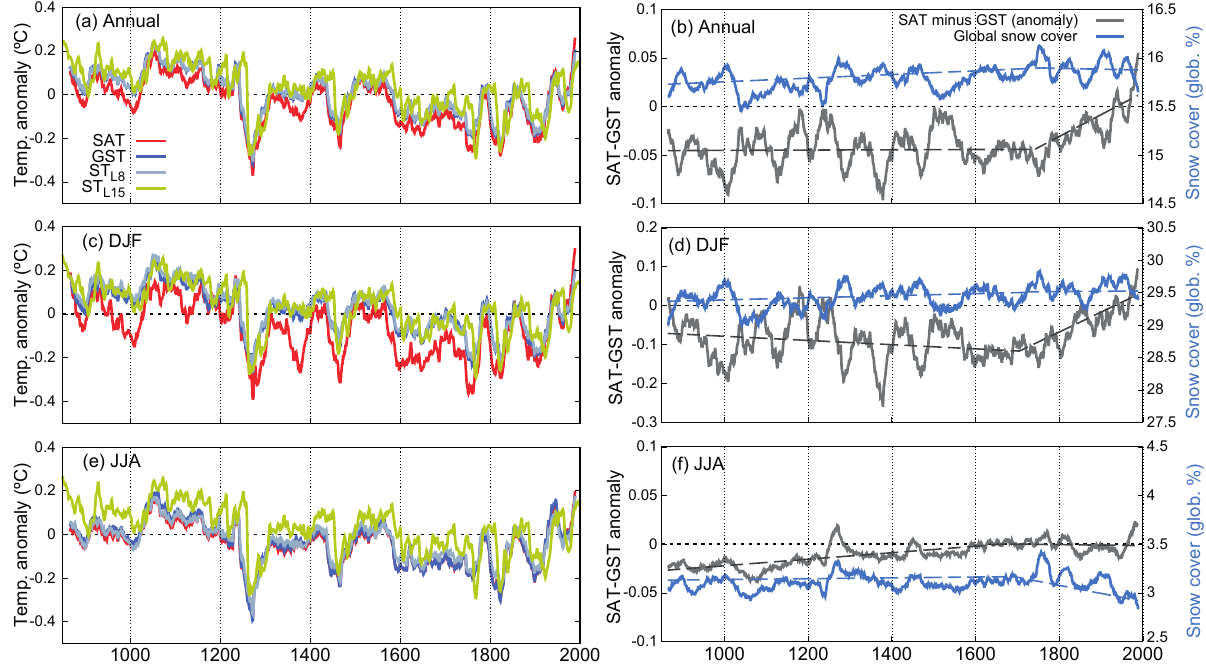
Figure 1. (a) Annual, (c) DJF and (e) JJA global LM evolution of SAT, GST, ST L8 and ST L15 anomalies relative to the 1850–2005CE period for the ALL- F 2 ensemble member. (b) Annual, (d) DJF and (f) JJA global LM evolution of the SAT–GST offset (SAT minus GST anomalies) and the global percentage of snow cover. Dashed lines are the result of a two-phase regression, indicating the linear trend that represents the best fit to the data before and after the estimated point of change. For snow cover, dashed lines represent linear fits to the data using the change points found for SAT–GST. All series are 31-year moving average filter outputs except for ST L15 , which is represented as the direct model